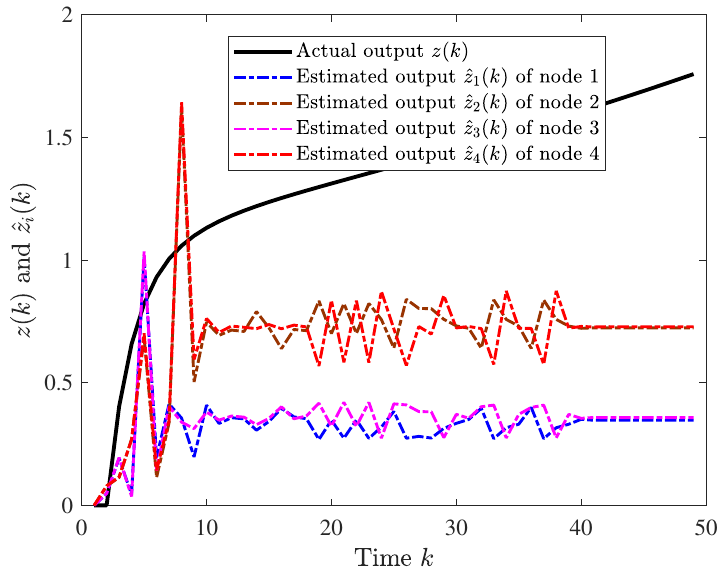
Figure 11. Evolution of system output z ( k ) and estimated output ˆ z i ( k ) in Case 4, i =